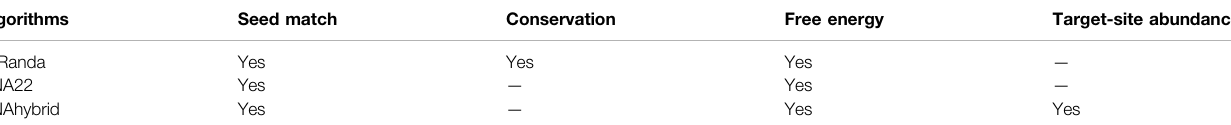
TABLE 1 | Common features of miRanda, RNA22 and RNAhybrid algorithms. Algorithms